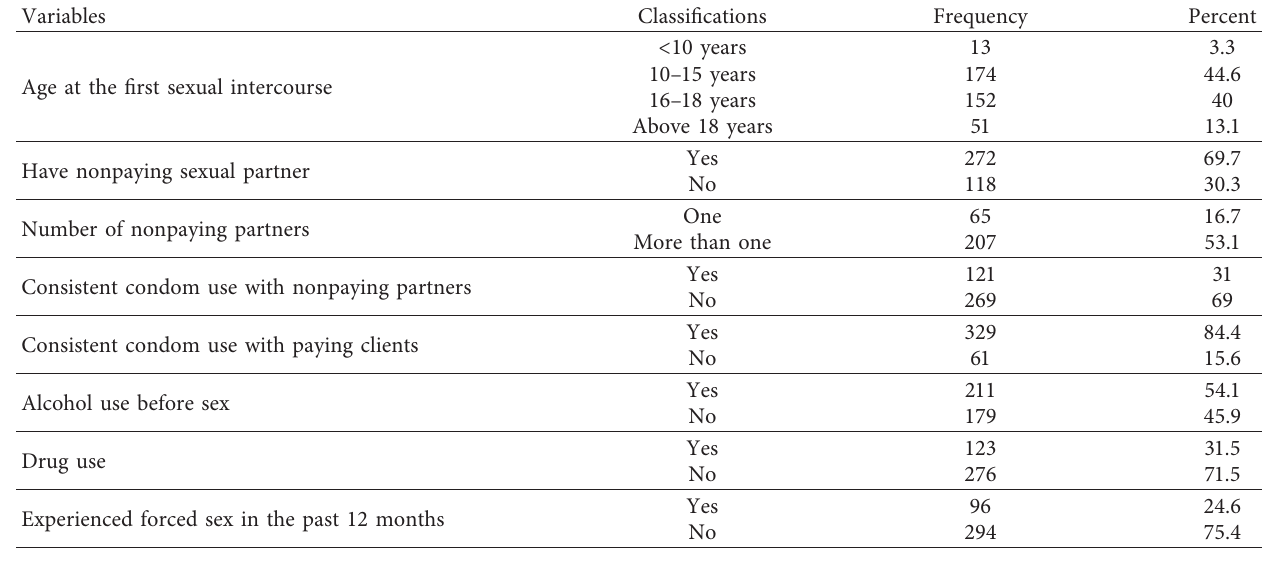
Table 2: Sexual behavior of FSWs working in licensed drinking establishments of Adama Town, Oromia regional state, Ethiopia, March 2017 ( N � 390).